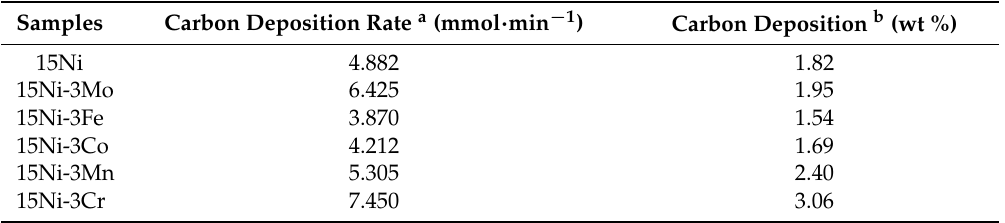
Table 2. Carbon deposition data of spent catalysts after performance tests.